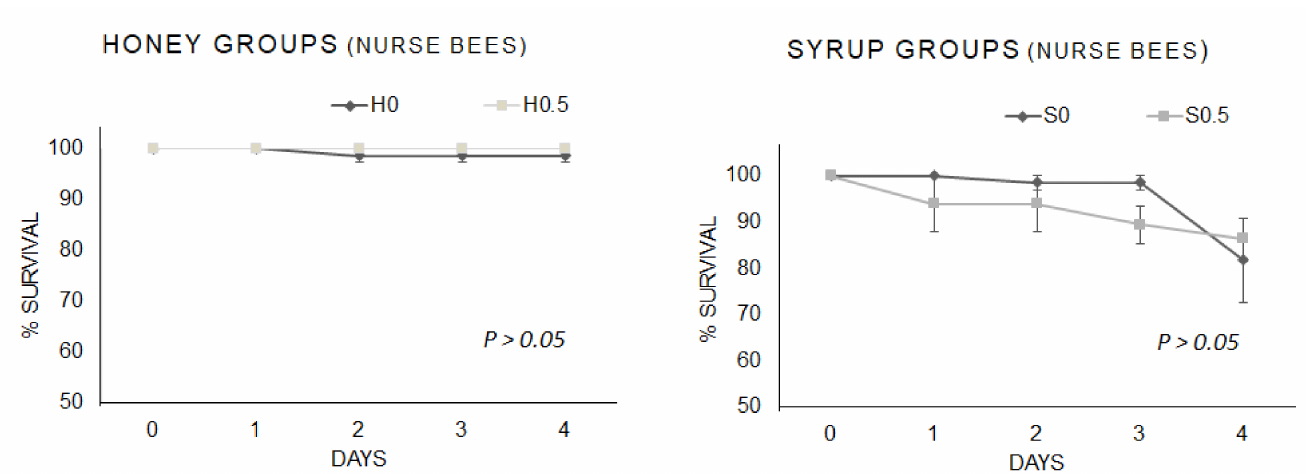
Figure 2. Survival rate of nurse bees fed base-diets (honey and syrup) enriched with β -glucans (0.5 % w / w ) and control groups. Each curve indicates the sum of three replicates per group. The bars indicate the standard error calculated on the survival of the three replicates per each group. H = honey; S = syrup; 0, 0.5 = % ( w / w ) 1,3-1,6 β